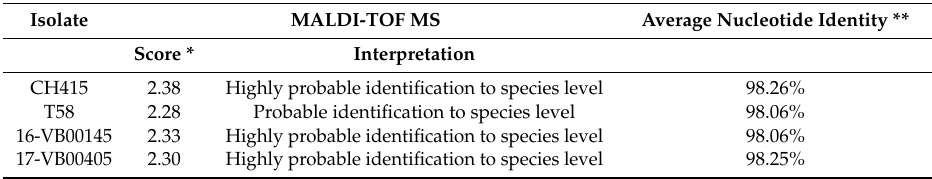
Table 3. Species confirmation by Matrix-assisted laser desorption / ionization time-of-flight mass spectrometry (MALDI-TOF MS) and average nucleotide identity